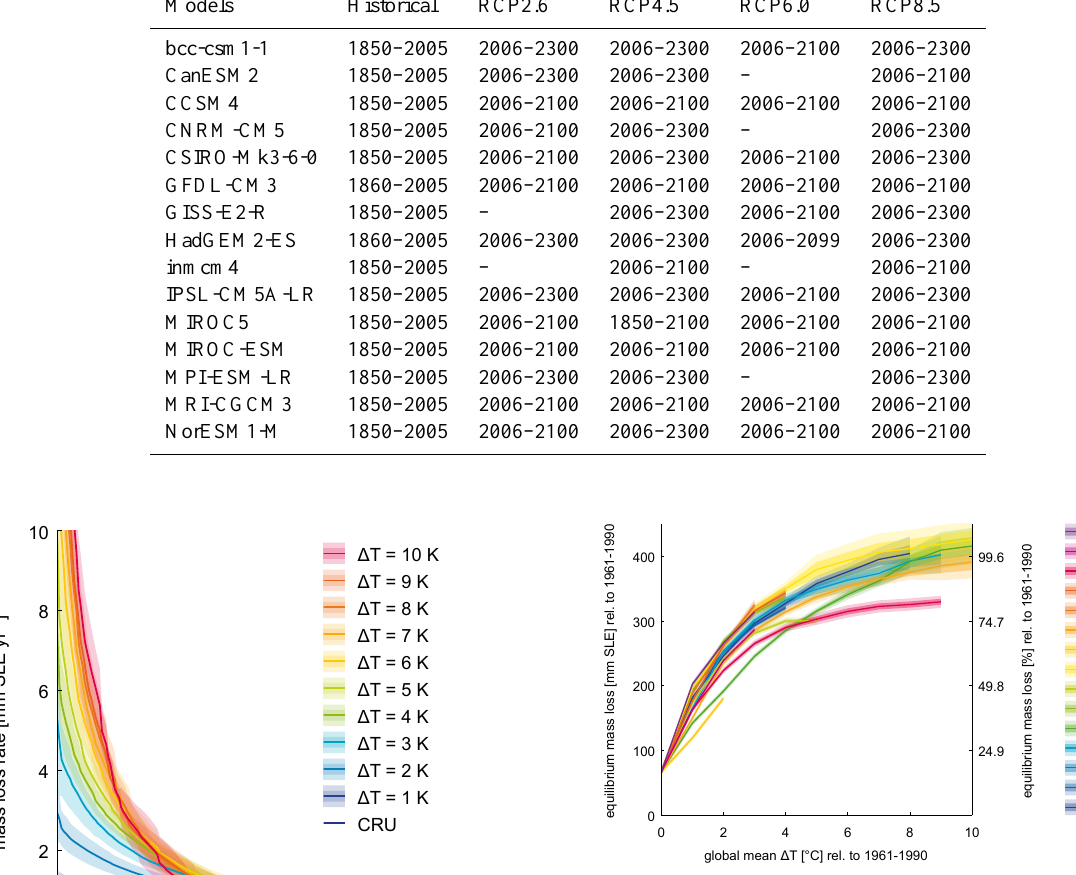
Fig. 2. Equilibrium mass loss of glaciers as a function of global mean temperature anomaly. Dark (light) shading indicates one (two) standard errors. Colors indicate which CMIP5 model was used for forcing. The volume estimates differ slightly between the models. Therefore, the mean of the volume estimates was used for the right axis, and values > 100% may occur for individual